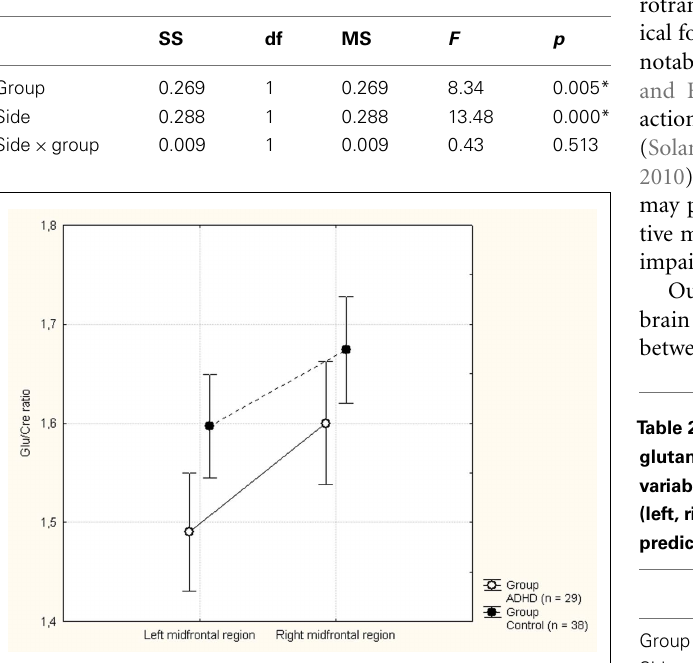
FIGURE 3 | Mean glutamate to creatine (Glu/Cre) ratio in the left and right midfrontal region in the attention-deficit/hyperactivity disorder (ADHD) and control groups. Vertical bars denotes 95% confidence